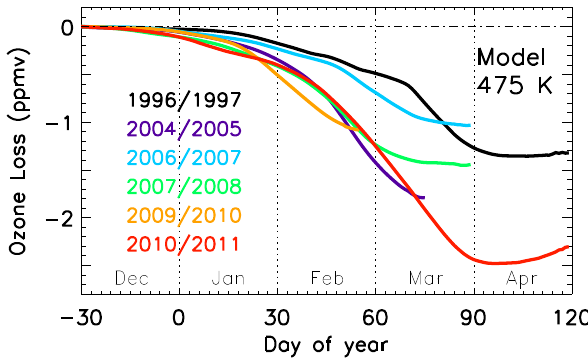
Fig. 7. Vortex-averaged ozone loss simulated by Mimosa-Chim for the Arctic winters 1996/1997 (black), 2004/2005 (violet), 2006/2007 (blue), 2007/2008 (green), 2009/2010 (yellow), and 2010/2011 (red) at 475 K. The dotted vertical lines mark approx- imate boundaries of each month and the dash-dotted horizontal line is 0 ppmv.